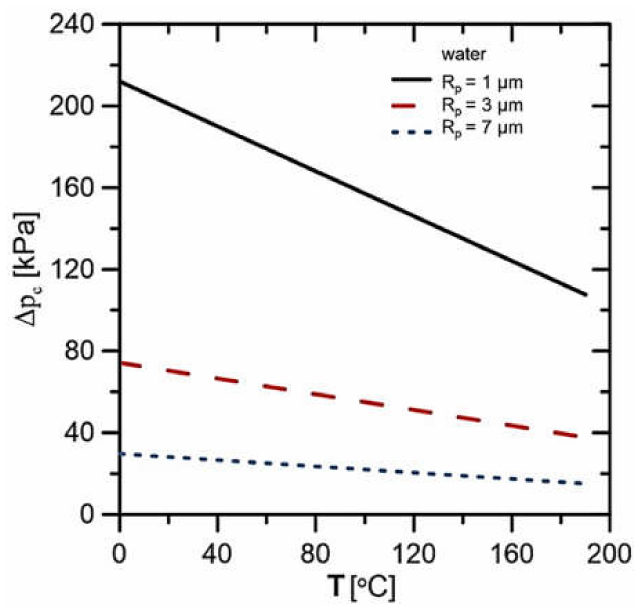
Figure 2. Capillary pressure rise characteristic for water as a working